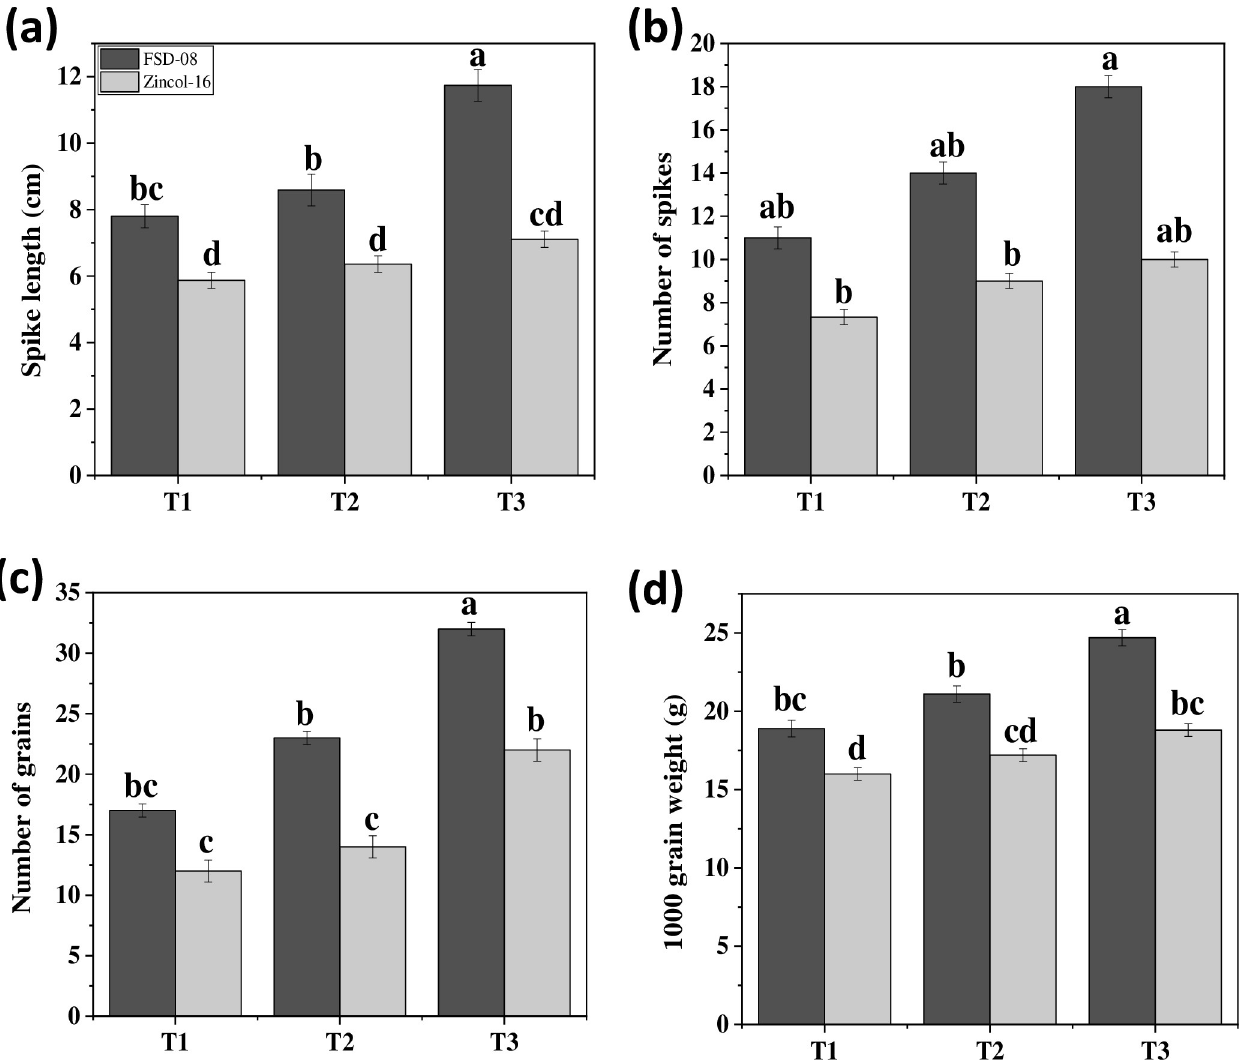
Fig 6. The effect of exogenous caffeic acid supply on (a) spike length, (b) number of spikes, (c) number of grains, and (d) 1000 grain weight of two wheat ( Triticum aestivum L.) varieties subjected to salt stress. The bar values depict the average of three replications and the bars not sharing the same lowercase letters differ significantly from each other according to the HSD test at P < 0.05 probability. Treatments include (T 1 ) Saline field EC 8.7 dS m -1 , (T 2 ) saline field + 50 μ M caffeic acid, (T 3 ) saline field + 100 μ M caffeic acid.